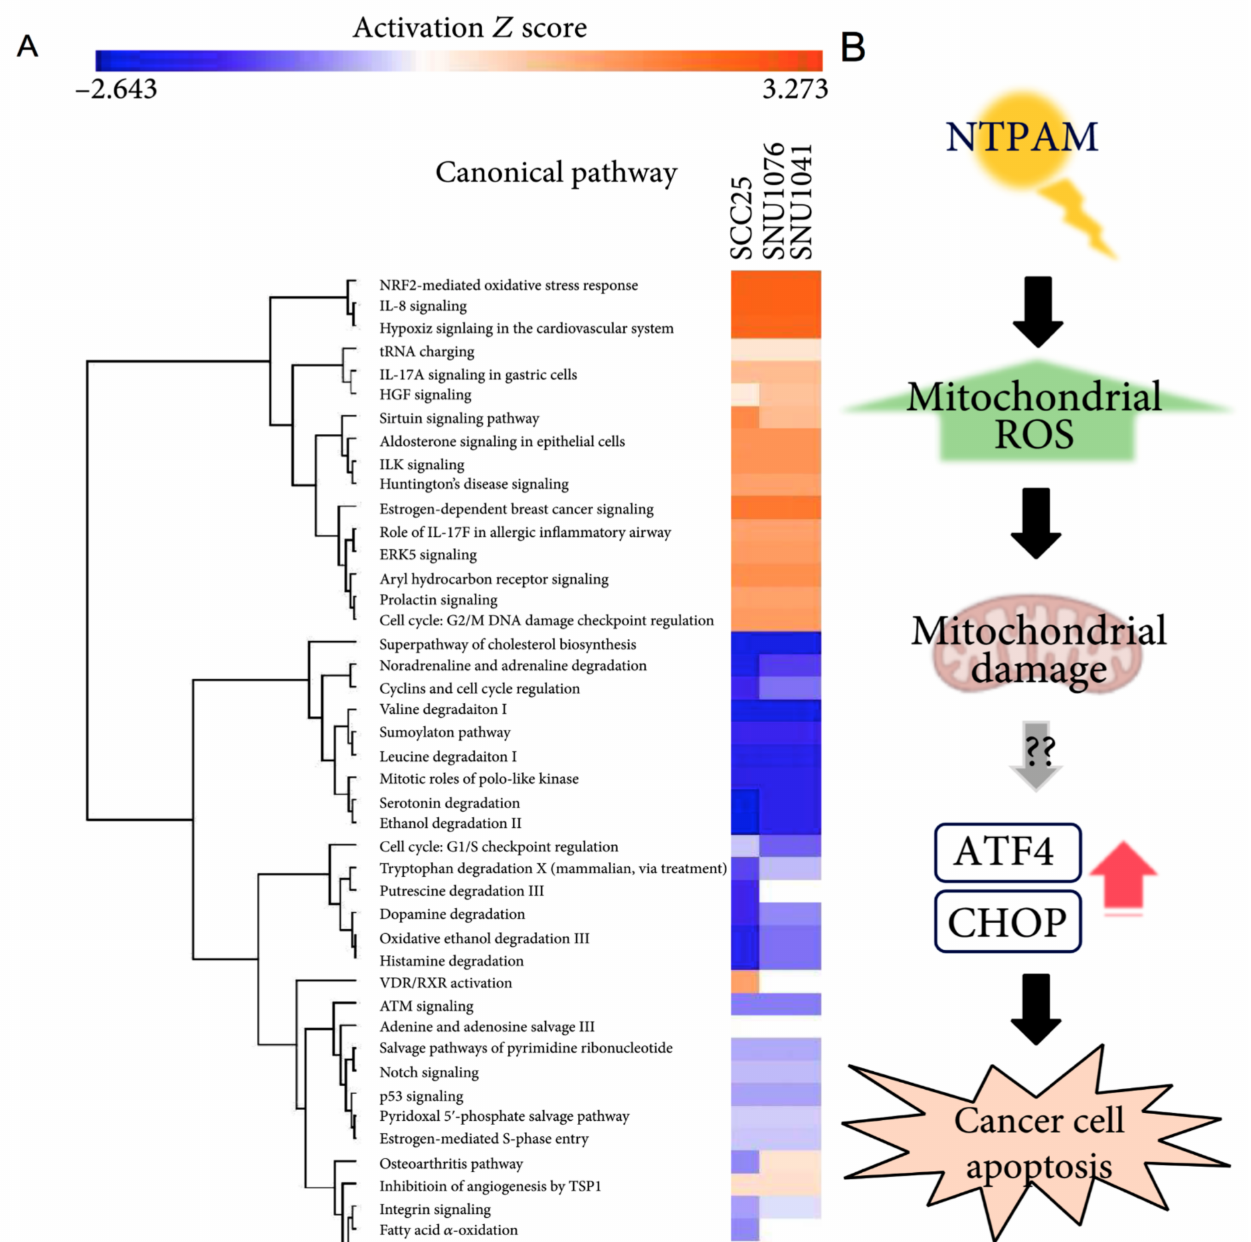
Figure 5. Mechanism and pathways induced by plasma-activated media treatment in head and neck cancer. ( A ) Top relevant canonical pathways associated with plasma activated media treatment by core analysis. ( B ) The proposed mechanism of plasma activated media based anti-cancer effects on head and neck cancer cells